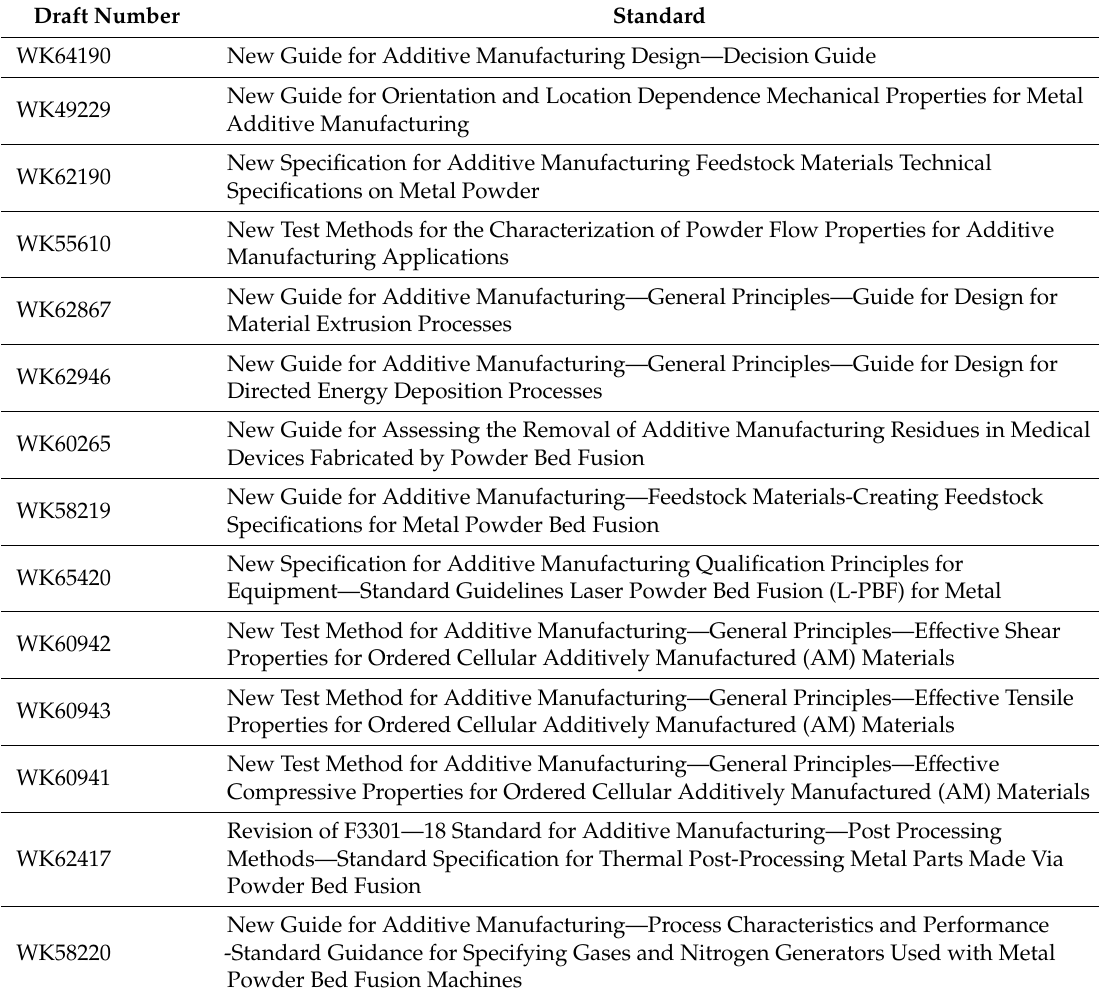
Table 2. Work in process of ISO / ASTM new guides for designing, manufacturing, and testing methods of AM